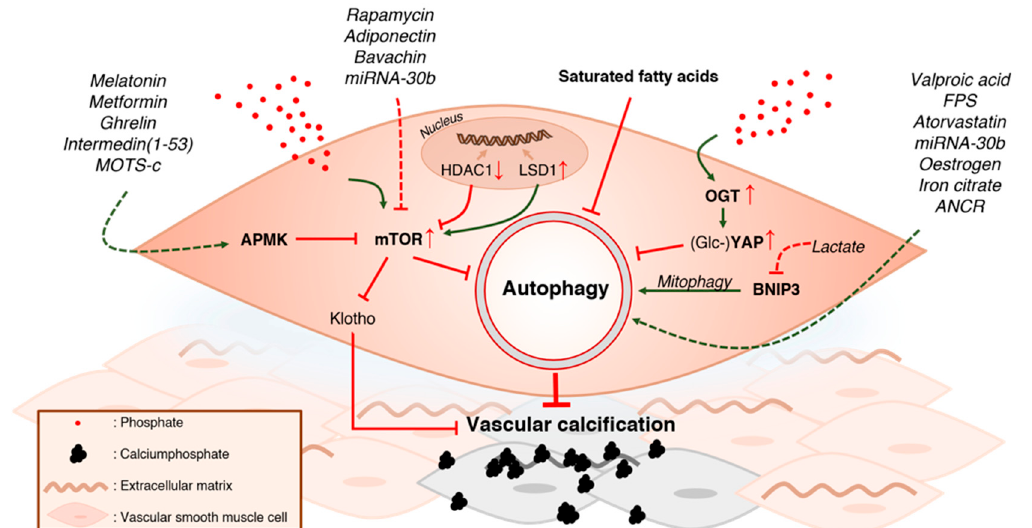
Figure 3. Modulating the autophagic machinery in vascular calcification. A high Pi environment promotes vascular smooth muscle cell (VSMC) calcification. This pro-calcific environment increases the activity of the mammalian target of rapamycin (mTOR), as well as O-GlcNAc transferase (OGT). The latter enhances YAP glycosylation. Additionally, epigenetic regulation of mTOR activity is also a ff ected by the high Pi environment. Histone deacetylase 1 (HDAC1) is downregulated, while lysine-specific histone demethylase A1 (LSD1) is upregulated, resulting in enhanced mTOR activity. Both the increase in glycosylated (Glc) YAP and mTOR activity inhibit autophagy, facilitating VSMC calcification. Therefore, direct or AMPK-mediated inhibition of mTOR, through the use of di ff erent pharmacological agents, alleviates mTOR-dependent suppression of autophagy and ameliorates VSMC calcification. Saturated fatty acids, which are present in the pro-calcific environment, as seen in patients with chronic kidney disease, inhibit autophagy and are shown to facilitate VSMC calcification. Stimulation of autophagy with various pharmacological agents has been shown to attenuate VSMC calcification. Lastly, BNIP3-mediated mitophagy plays an important role in VSMC calcification, as inhibition of this pathway with lactate, promotes mineralization. AMPK = AMP-activated kinase, mTOR = mammalian target of rapamycin, HDAC1 = Histone deacetylase 1, LSD1 = Lysine-specific histone demethylase A1, OGT = O-GlcNAc transferase, Glc = Glycosylated, YAP = Yes-associated protein, BNIP3 = BCL2 and adenovirus E1B 19-kDa-interacting protein 3, ANCR = anti-di ff erentiation non-coding